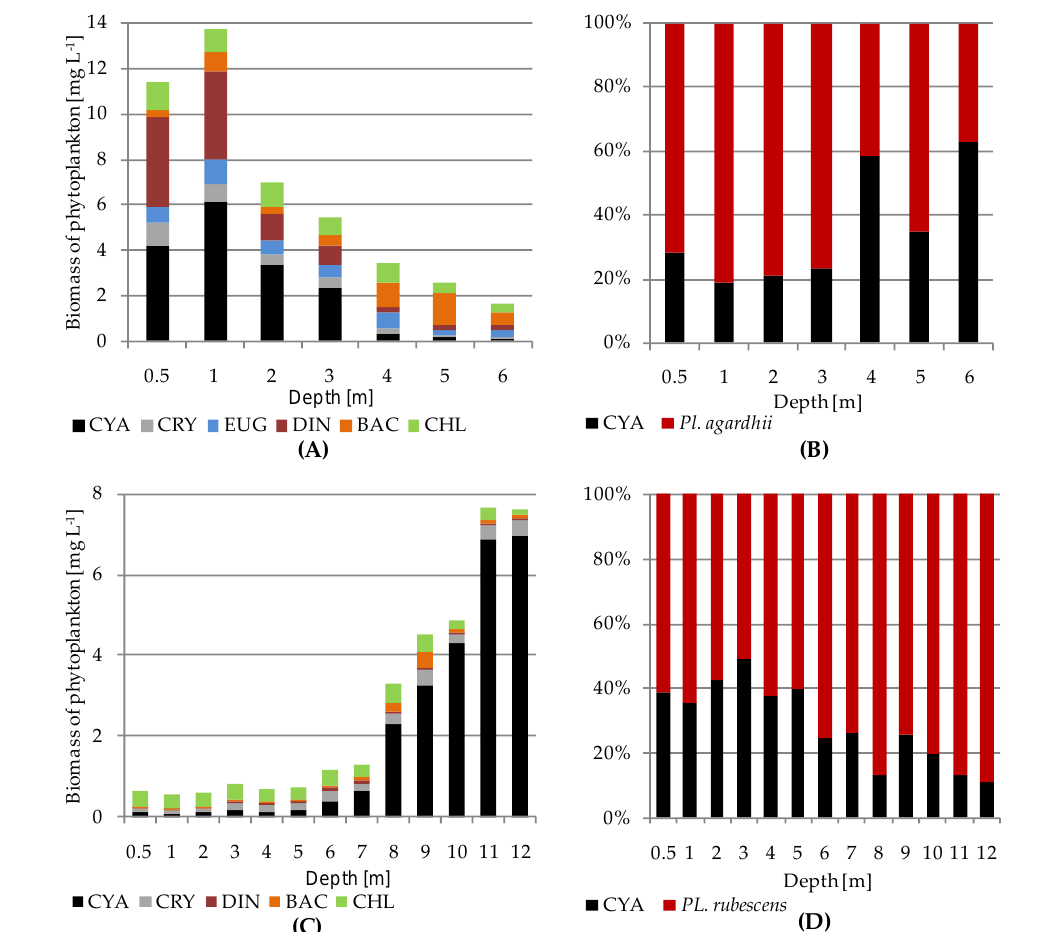
Figure 3. Vertical variation of mean values of the phytoplankton biomass and percentage shares of the genus Planktothrix in the Cyanoprokaryota group in Lake Glinki ( A , B ) and in Lake Piaseczno ( C , D ). Explanations: CYA, Cyanoprokaryota; CRY, Cryptophyceae; EUG, Euglenophyceae; DIN, Dinophyceae; BAC, Bacillariophyceae; CHL, Chlorophyta. Table 2. Spearman ’s rank correlation matrix (r) of Planktothrix agardhii biomass in Lake Glinki ( n = 35) and Planktothrix rubescens biomass in Lake Piaseczno ( n = 65) and selected environmental pa- rameters (bold numerals for p < 0.001; italic numerals for p < 0.05). Parameters P. agardhii